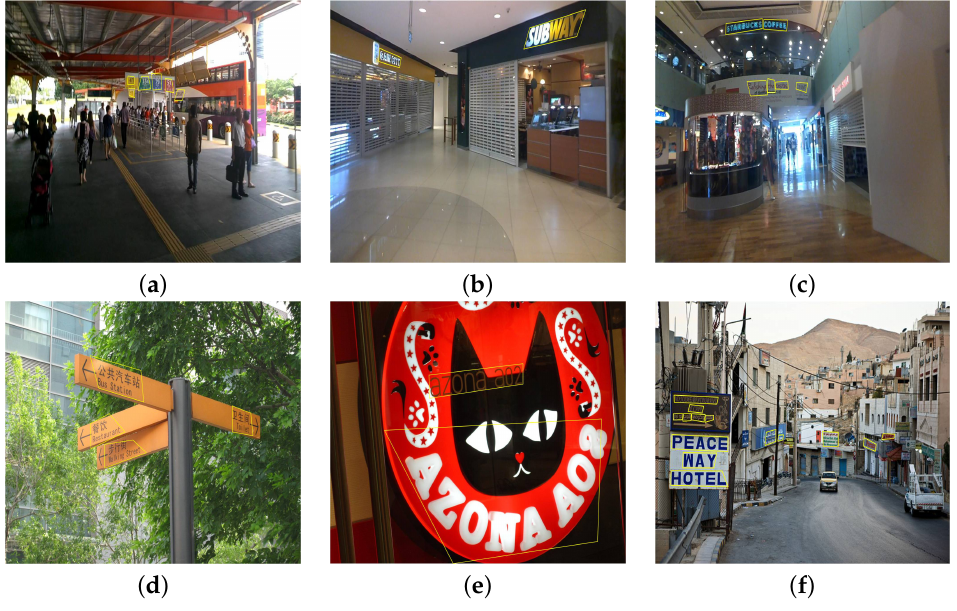
Figure 3. MobileTDNet output for sample difficult cases displayed in subfigures ( a – f ). Table 3. MobileTDNet detection results with attention blocks: comparison with recent